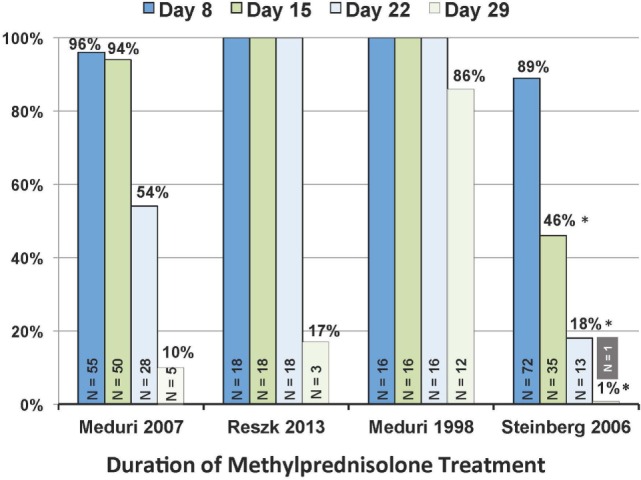
Patients, in each trial, alive on study day 8, 15, 22, and 29 that received at least 7, 14, 21, and 28 days of methylprednisolone treatment. N value within each column reports patients alive on the specified day. *P < 0.001 in comparison to the other three trials. Reproduced with permission (58).